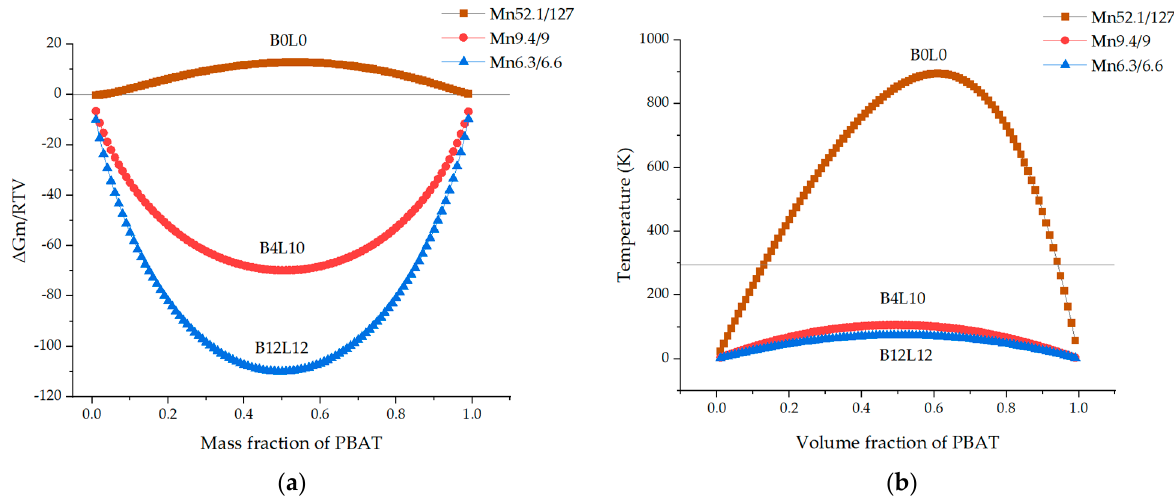
Figure 7. Miscibility simulation based on Su’s method [24]: ( a ) Phase diagram and ( b ) spinodal curves of PBAT/PLA blends: B0L0, B4L10, and B12L12 at 293 K.